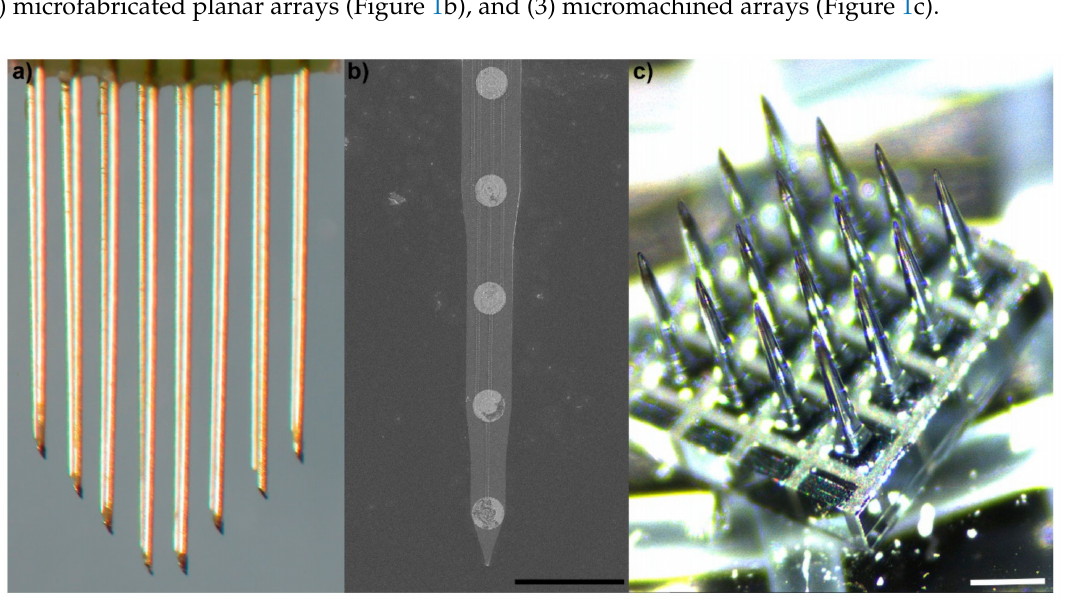
Figure 1. Classes of microscale implantable neural technologies: ( a ) 50 µ m polyimide-insulated tungsten microwire with chiseled tips (Tucker–Davis Technologies, Alachua, FL, USA); ( b ) microfabricated silicon Michigan array with iridium electrode sites (NeuroNexus Technologies, Ann Arbor, MI, USA), scale = 100 µ m; ( c ) macromachined boron-doped silicon array (Blackrock Microsystems, Salt Lake City, UT, USA), each needle is electrically separated at the base with glass. Scale = 400 µ